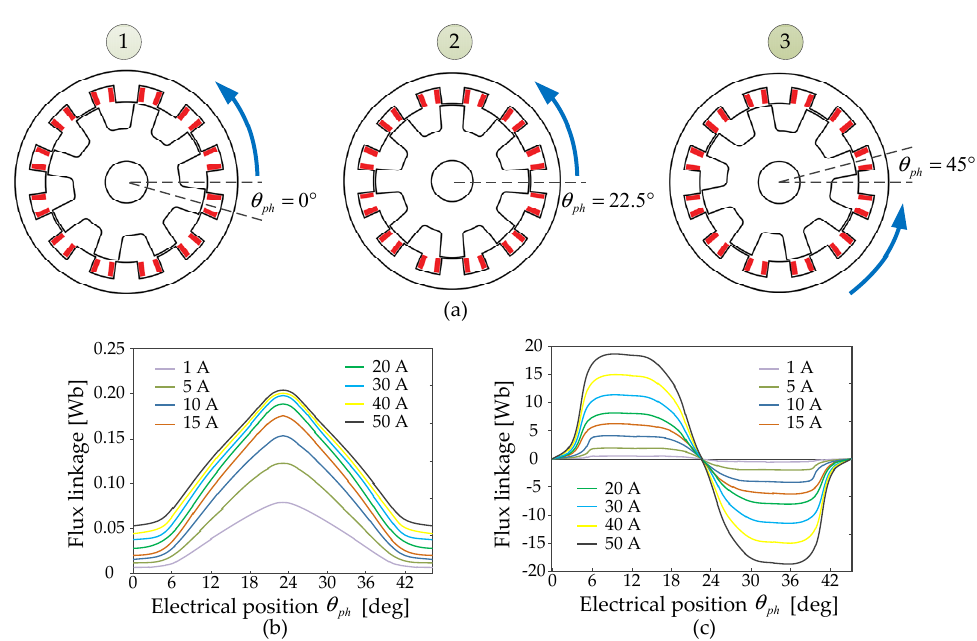
Figure 5. SRM structure topology of a three-phase 12/8 poles and electromagnetic properties. ( a ) Rotor electrical angle. ( b ) Magnetization curve. ( c ) Phase torque curve. The motor conforms to the law of electromagnetic induction in the process of